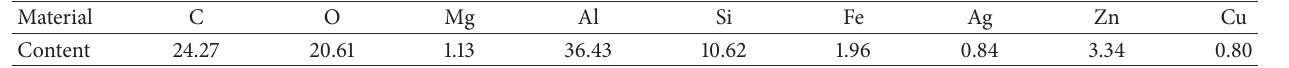
Table 2: Chemical composition of silicon carbide based aluminum metal matrix composite.